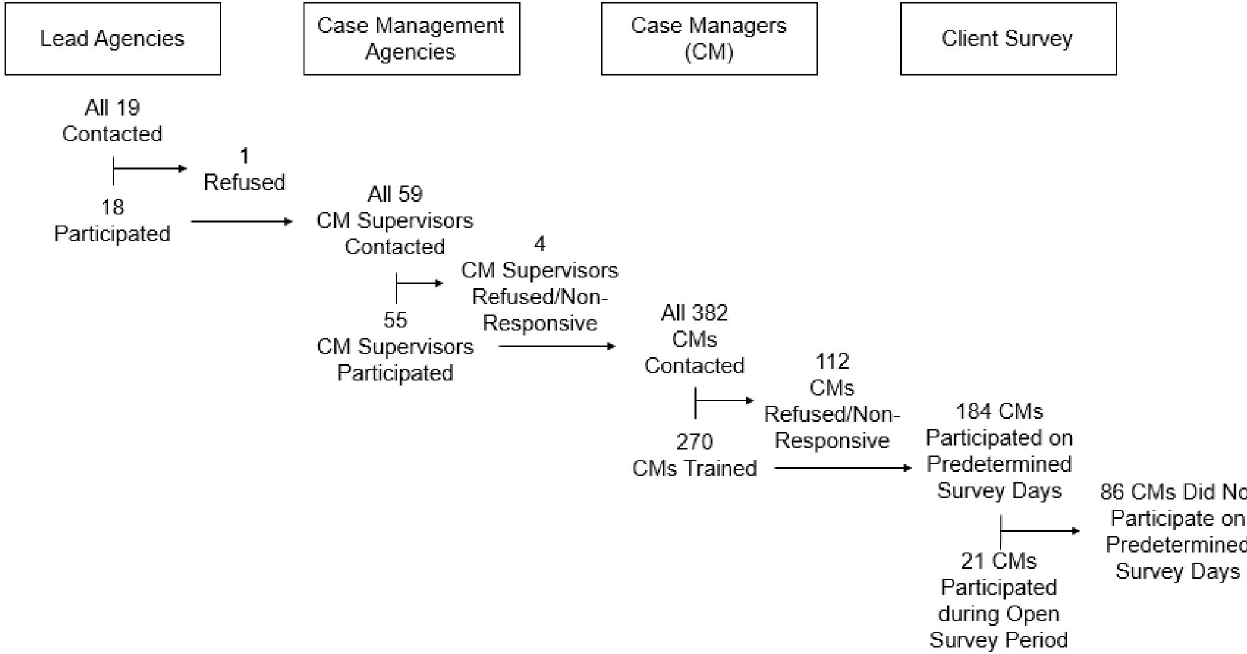
Fig 2. Proportion of participation for survey completion. Note: Not all CMs were invited to participate in Post predetermined survey days due to completion of survey goals.